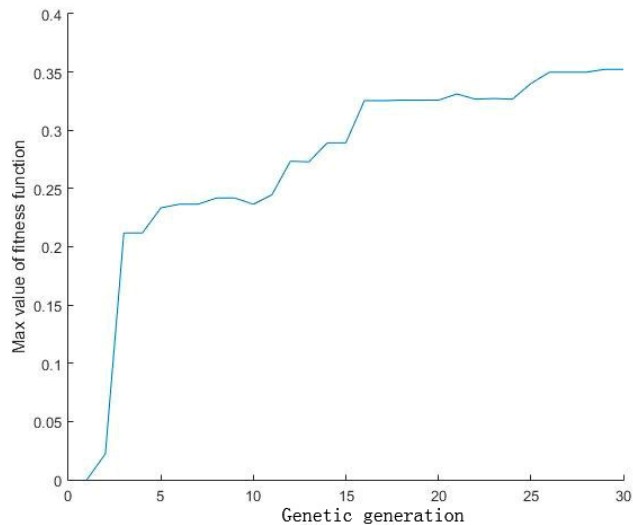
Figure 7. The relationship between the fitness function value and the generation.